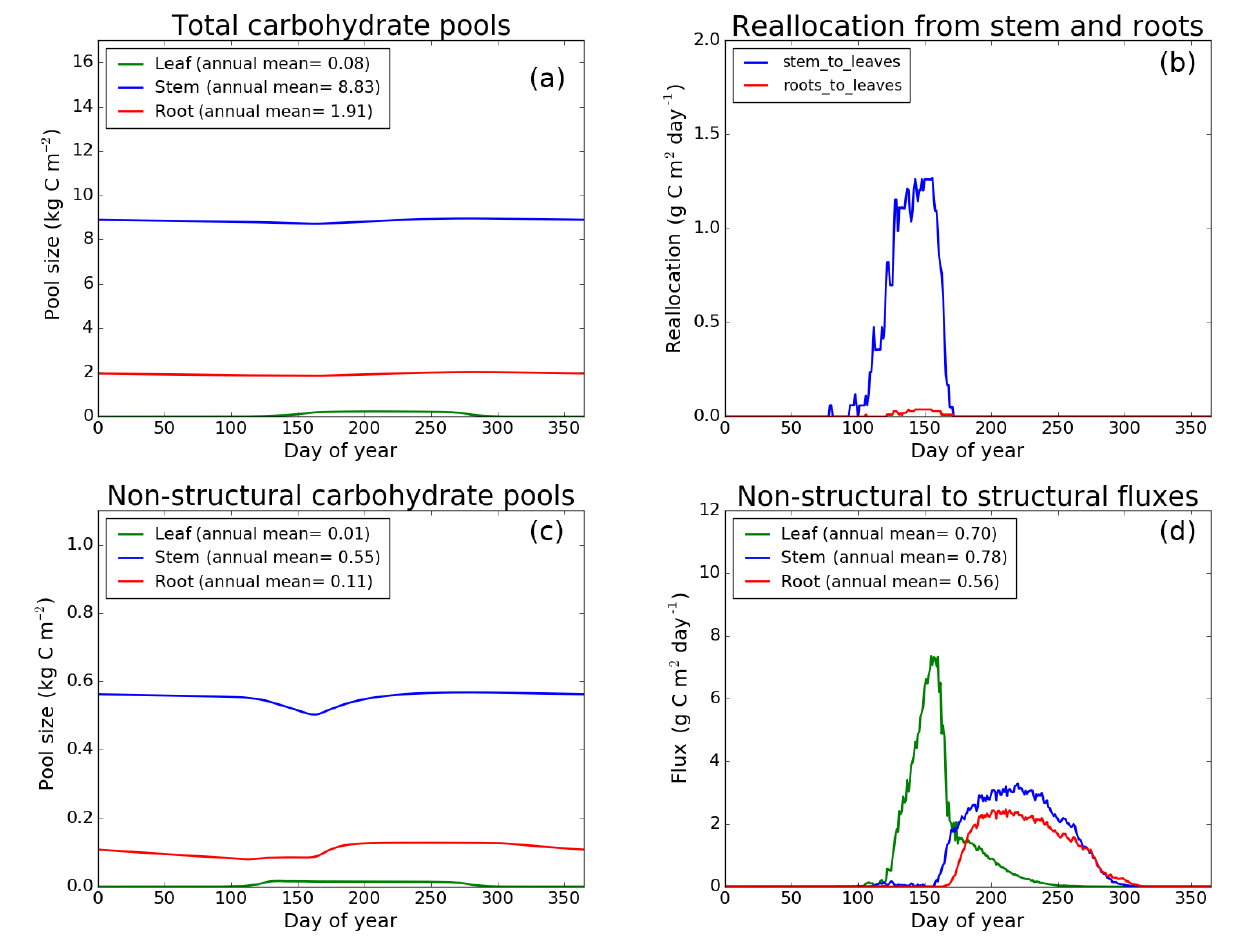
Figure 7. CLASS–CTEM (modified version) simulated values of total (a) and non-structural (c) carbohydrate pools (kgCm − 2 ). Panel (b) shows the reallocation of carbon from non-structural stem and root pools to leaves during leaf onset in spring and panel (d) shows the carbon flux from non-structural to structural pools for leaf, stem, and root components (gCm − 2 day − 1 ) for the US-Ha1 (Harvard Forest) FLUXNET site. The plots show mean daily values across all years for which the meteorological data were available after the model pools reached